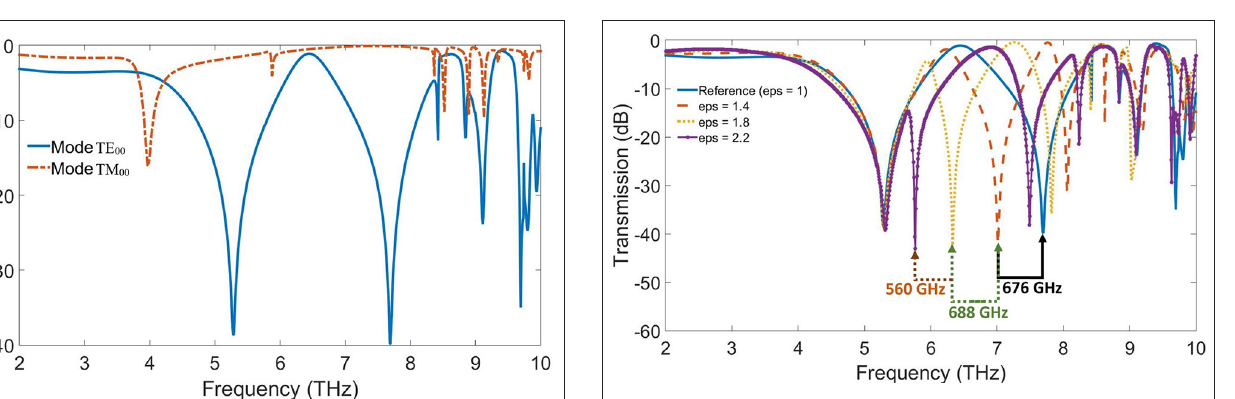
FIGURE 2 | Comparison between two dominant resonances for different propagation modes. Mode 1, which corresponds to the lower propagation mode, shows greater Q-factors than second resonance mode. Multiple resonances are activated for different propagation modes of the structure. One of the resonance frequencies corresponds to mode TM 00 , and the other one denotes TE 00 . This diagram depicts that the resonances for mode TE 00 are more suitable for the sensing purpose thanks to the higher Q-factor of just above − 40 dB.